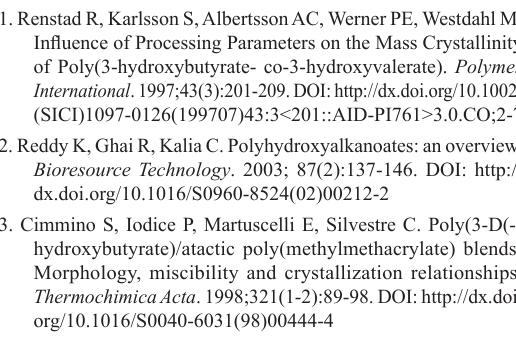
Table 2: Mechanical properties and of PHB and PHB Exposure Tensile Strength time (weeks) (MPa)